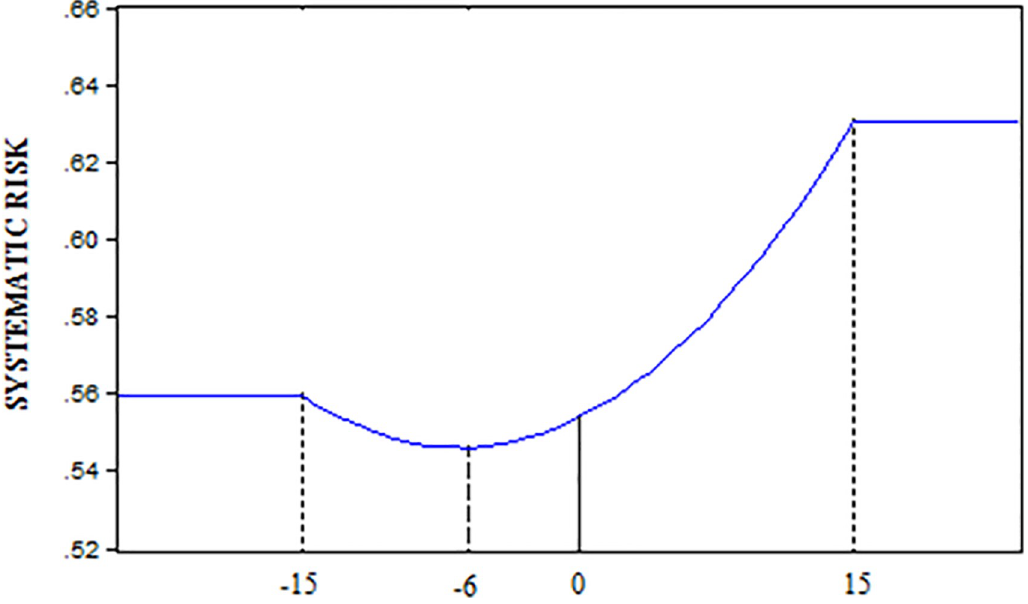
Fig 2. Systematic risk pre-crisis ([-15,+15] window). Fig 2 Displays the evolution of the systematic risk within the window [-15, +15] centered on the pre-crisis registry date. This information is based on the results of Table 3, obtained using 254